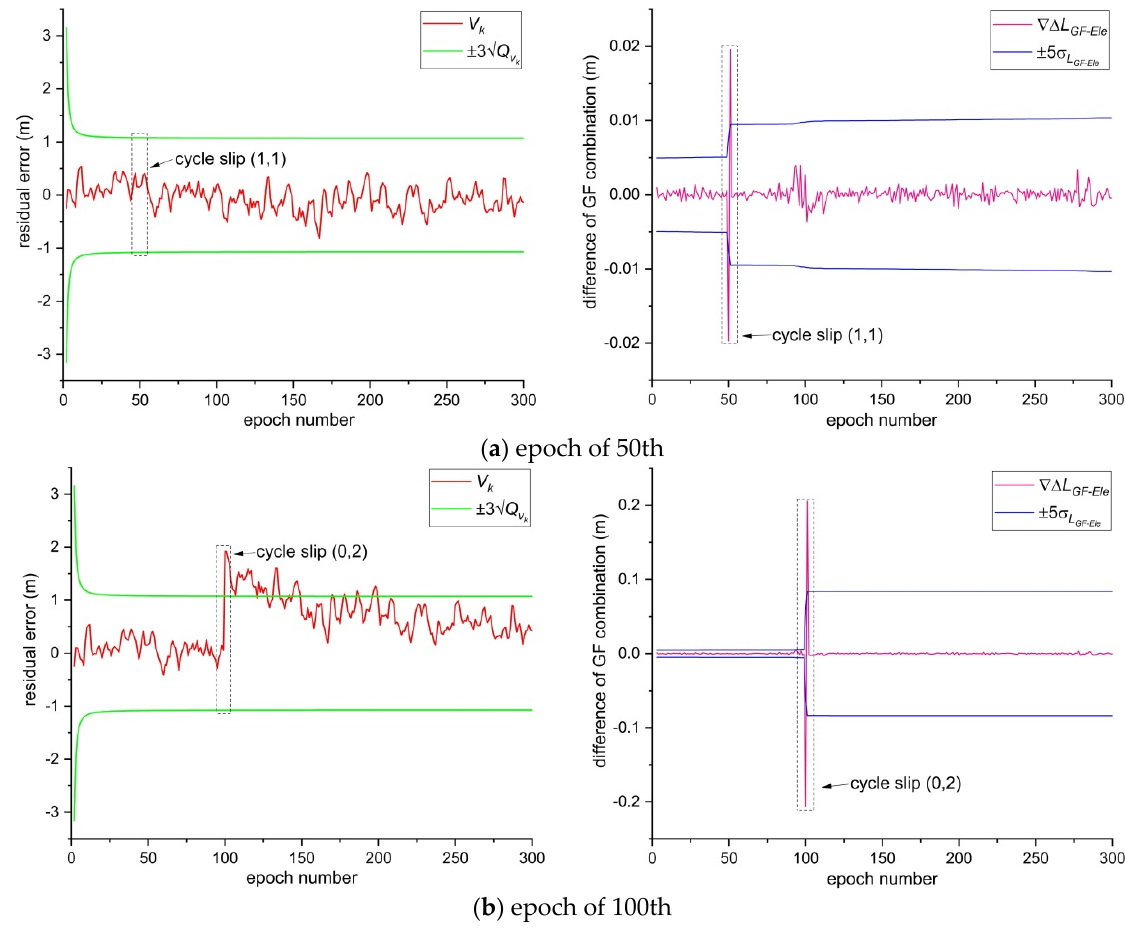
Figure 11. Cycle slip detection results of satellite G10 at different epochs under dynamic sea environment.